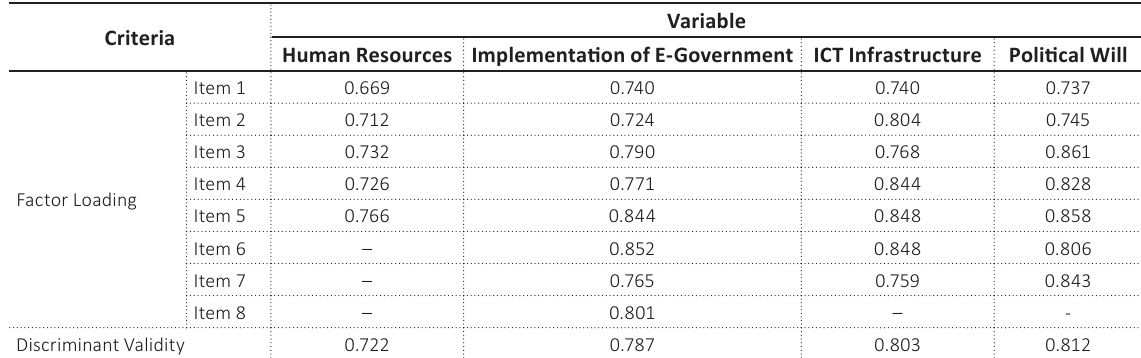
Table 2. Validity test results